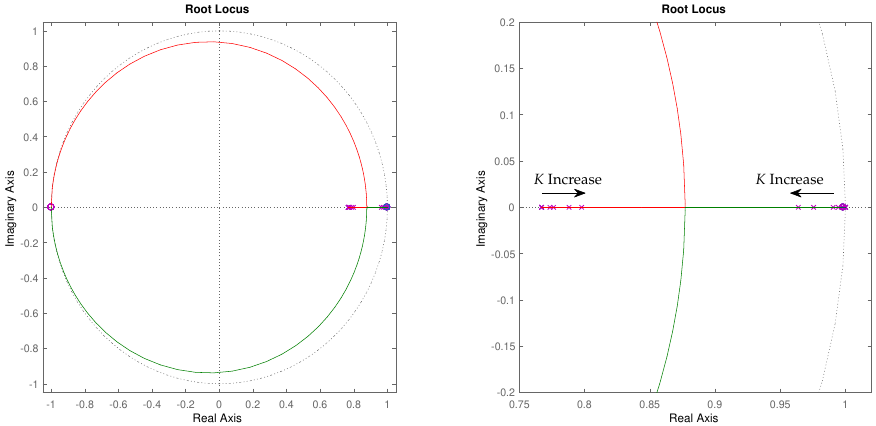
Figure 15. Root locus for the linear controllers obtained.